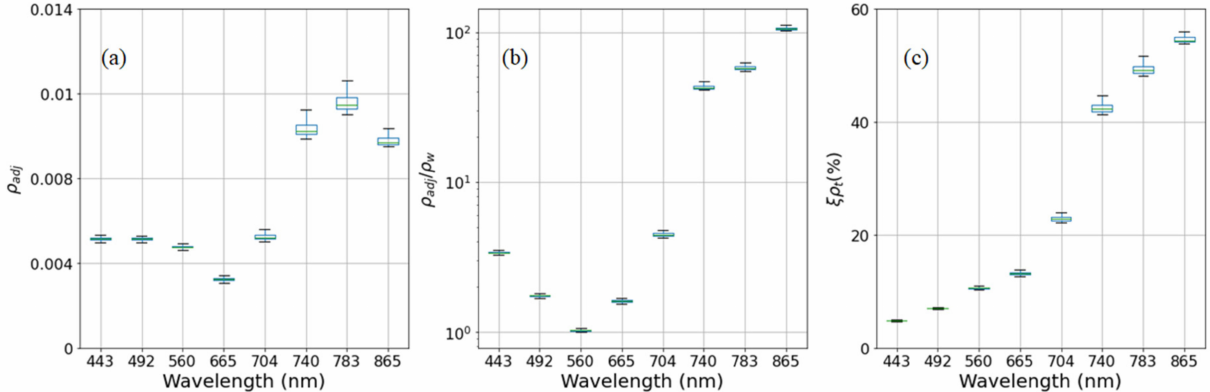
Figure 17. Boxplots of ρ adj ( a ), ρ adj / ρ w ( b ) and ξρ t ( c ) at different waveband over the